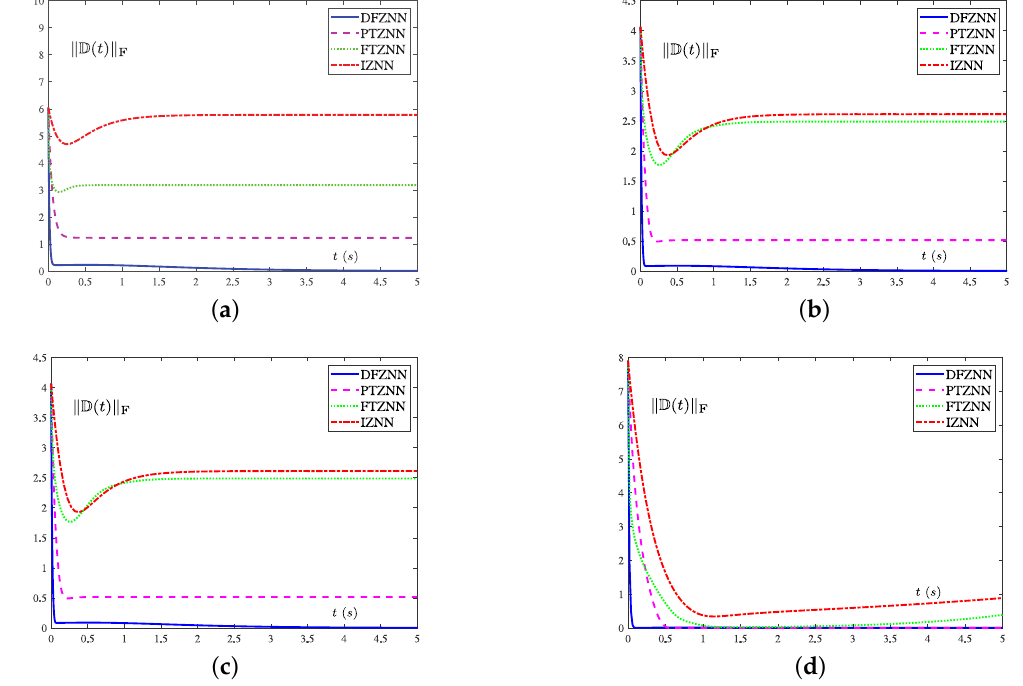
Figure 4. Trajectories of state solution of the DFZNN, PTCZNN, LTCZNN, IZNN with the activation